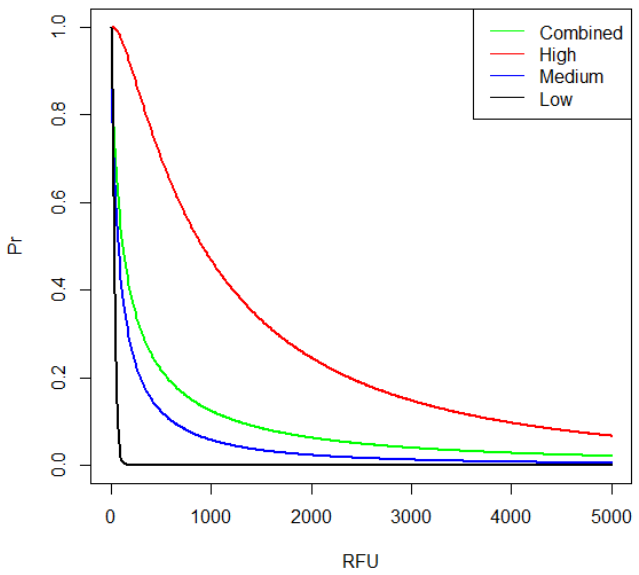
Figure 11. Effect of high/medium/low shedder status on direct transfer (E1) data.